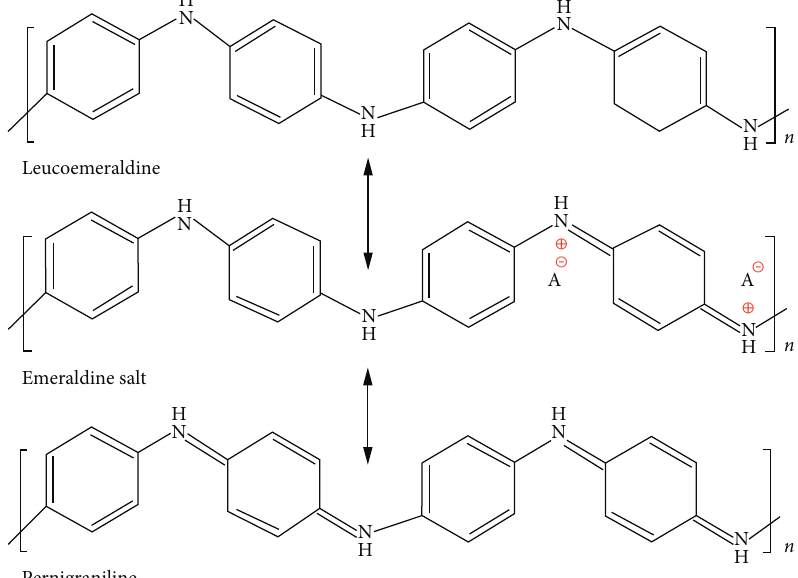
Figure 1: Molecular design of oxidation states of polyaniline, where A − denotes anionic